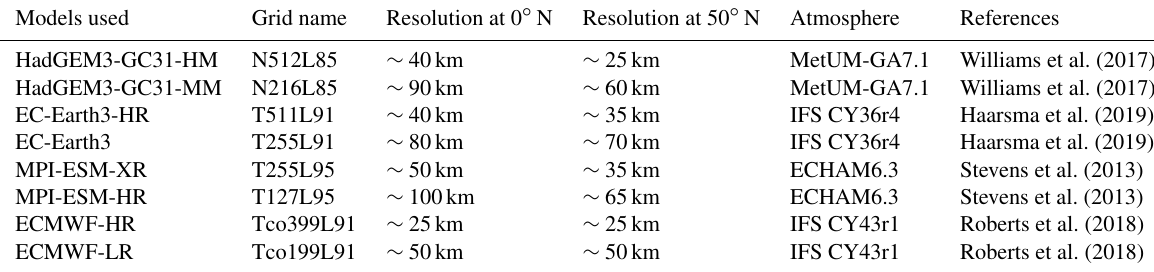
Table 1. List of the models analyzed in this study. Models